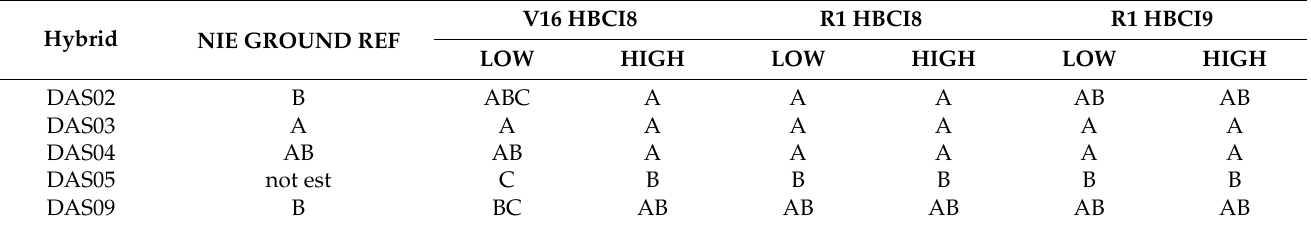
Table 11. NIE hybrid rankings at ACRE for HSI of interest at low and high spatial resolution. Hybrid rankings are based on a Tukey–Kramer HSD hybrid means comparison; hybrids with the same letter are not significantly